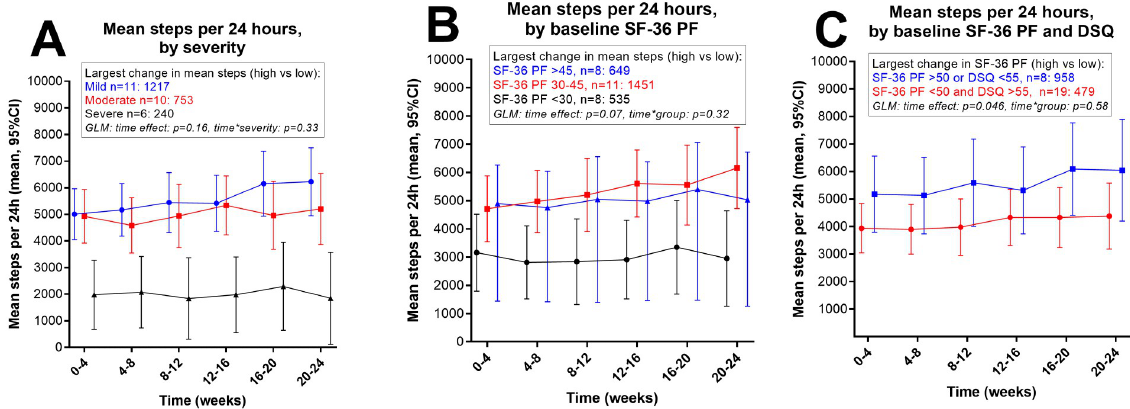
Fig 3. Steps per 24 hours, by severity, by SF-36 physical function, and by combination of SF-36 physical function and DSQ-SF. (A) Steps per 24 hours (mean, 95% CI) during follow-up, by severity categories; Mild, Moderate and Severe. (B) Steps per 24 hours (mean, 95% CI) during follow-up, by three categories based on baseline SF-36 PF. (C) Steps per 24 hours (mean, 95% CI) during follow-up, in two groups based on; SF-36 PF > 50 or DSQ-SF < 55, versus SF-36 PF < 50 and DSQ-SF > 55. The largest changes in mean steps between 4-week time periods, with difference highest versus lowest are indicated. General Linear Model (GLM) for repeated measures with p values for time effect and for interaction time-by-group are